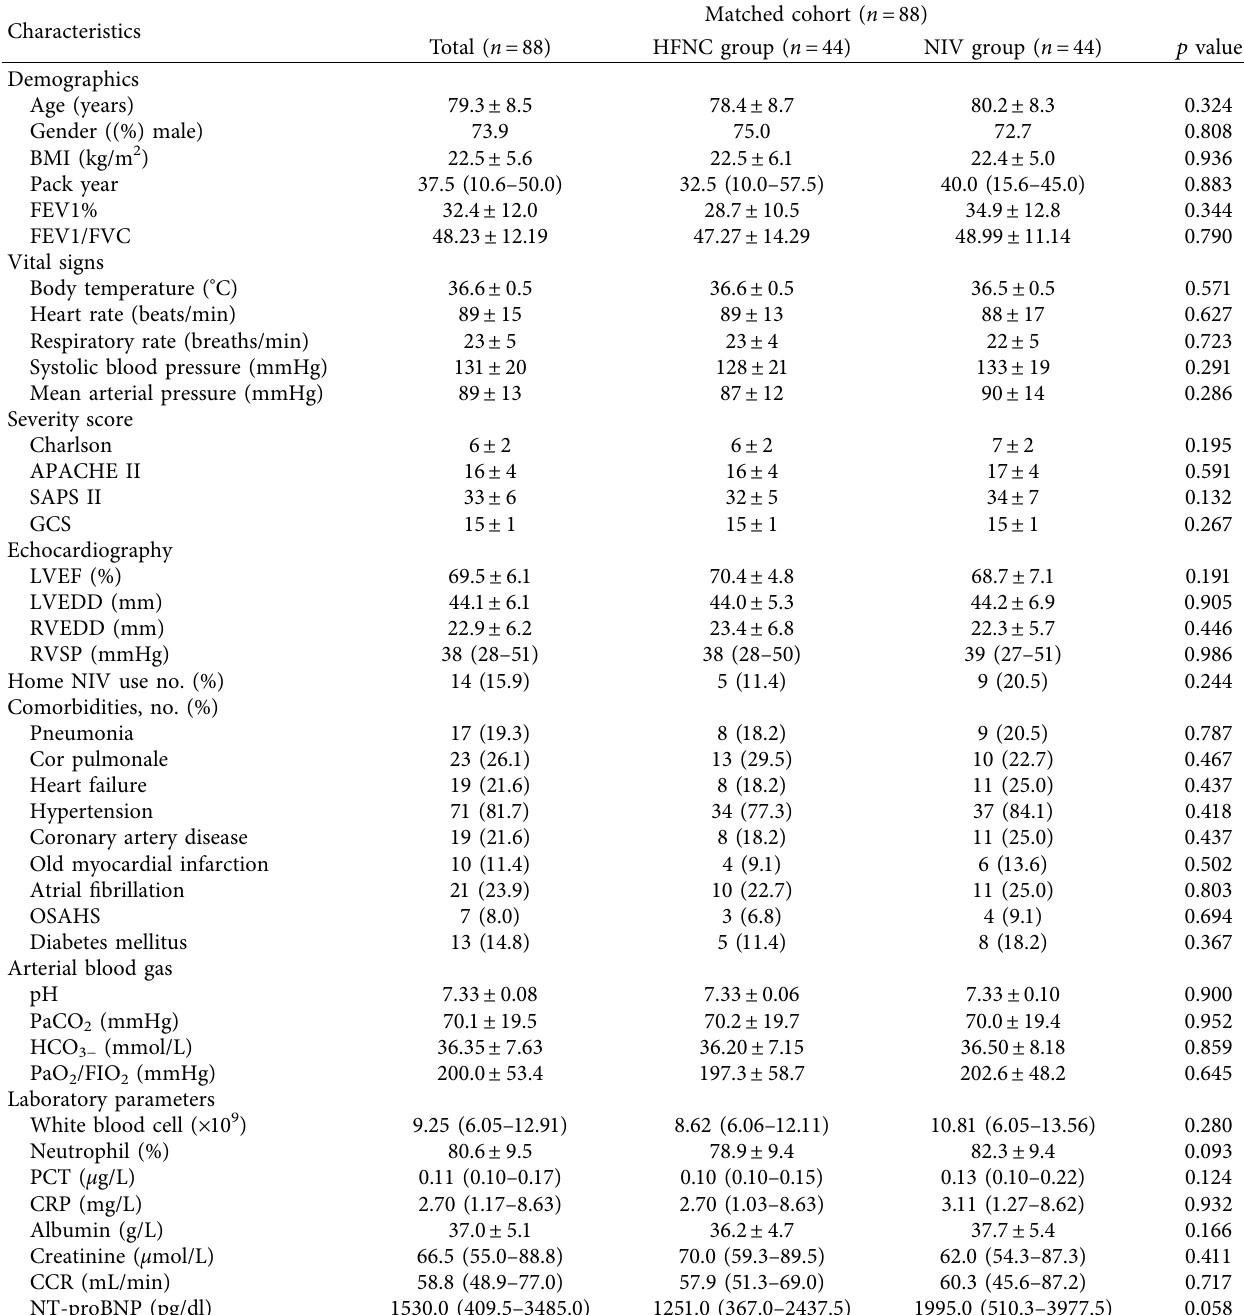
Table 2: Baseline characteristics at the time of ICU admission after propensity score